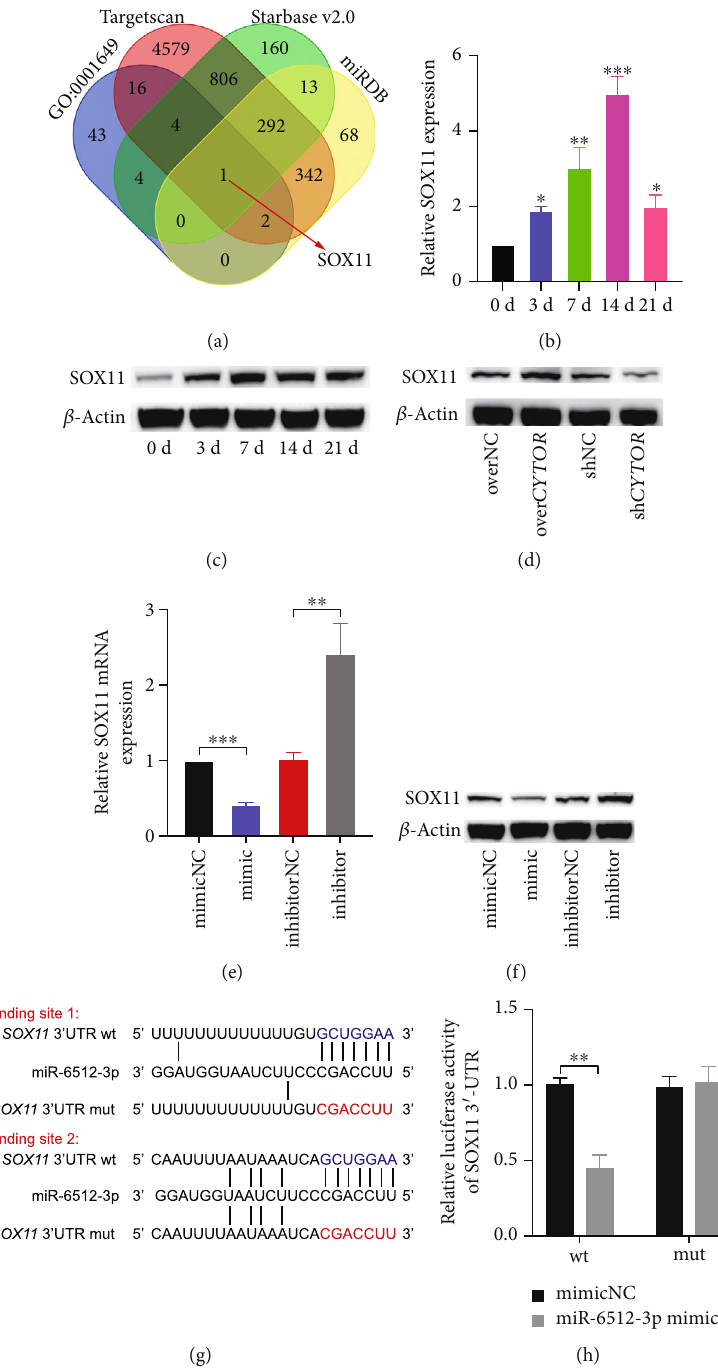
Figure 4: SOX11 is upregulated during osteogenic di ff erentiation of PDLSCs and is modulated by CYTOR and miR-6512-3p. (a) A Venn diagram of the intersections between the target genes of miR-6512-3p predicted on several online systems (TargetScan, StarBase, and miRDB) and the highly expressed genes from GO:0001649. (b, c). SOX11 mRNA (b) and protein (c) levels were determined by qRT- PCR and western blot during osteogenic di ff erentiation of PDLSCs. (d) E ff ects of overexpression or knockdown of CYTOR on the protein level of SOX11. (e, f) The mRNA and protein levels of SOX11 were evaluated by qRT-PCR and western blot in PDLSCs after transfection of miR-6512-3p mimic/inhibitor or their respective control. (g) Diagrammatic sketch of the binding sequences for the wt (blue) and mut (red) of SOX11 mRNA 3 ′ UTR associated with miR-6512-3p. (h) Luciferase activity of SOX11 mRNA 3 ′ UTR wt/mut cotransfected with miR-6512-3p mimic or mimic NC. ∗ p < 0 : 05 , ∗∗ p < 0 : 01 , and ∗∗∗ p < 0 : 001 . All tests were performed at least three times, and the values are presented as the mean ± SEM